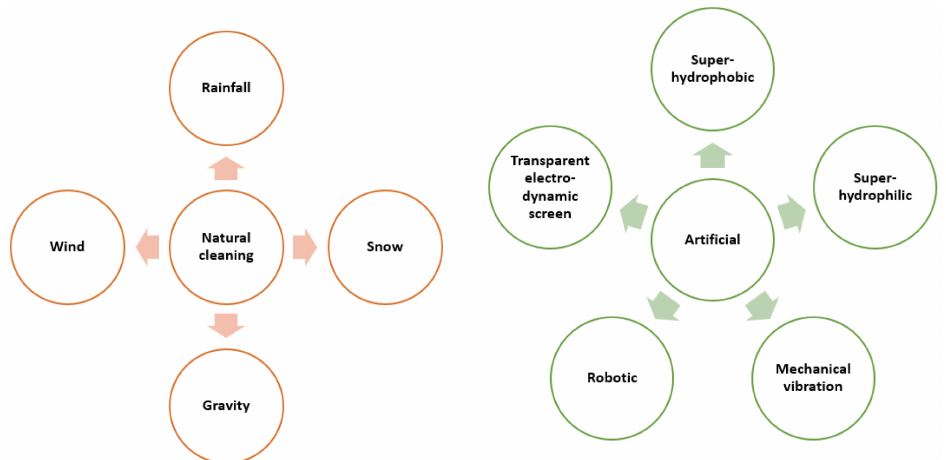
Figure 6. Different cleaning methods for removing dust from solar collectors. Adapted from Ref.